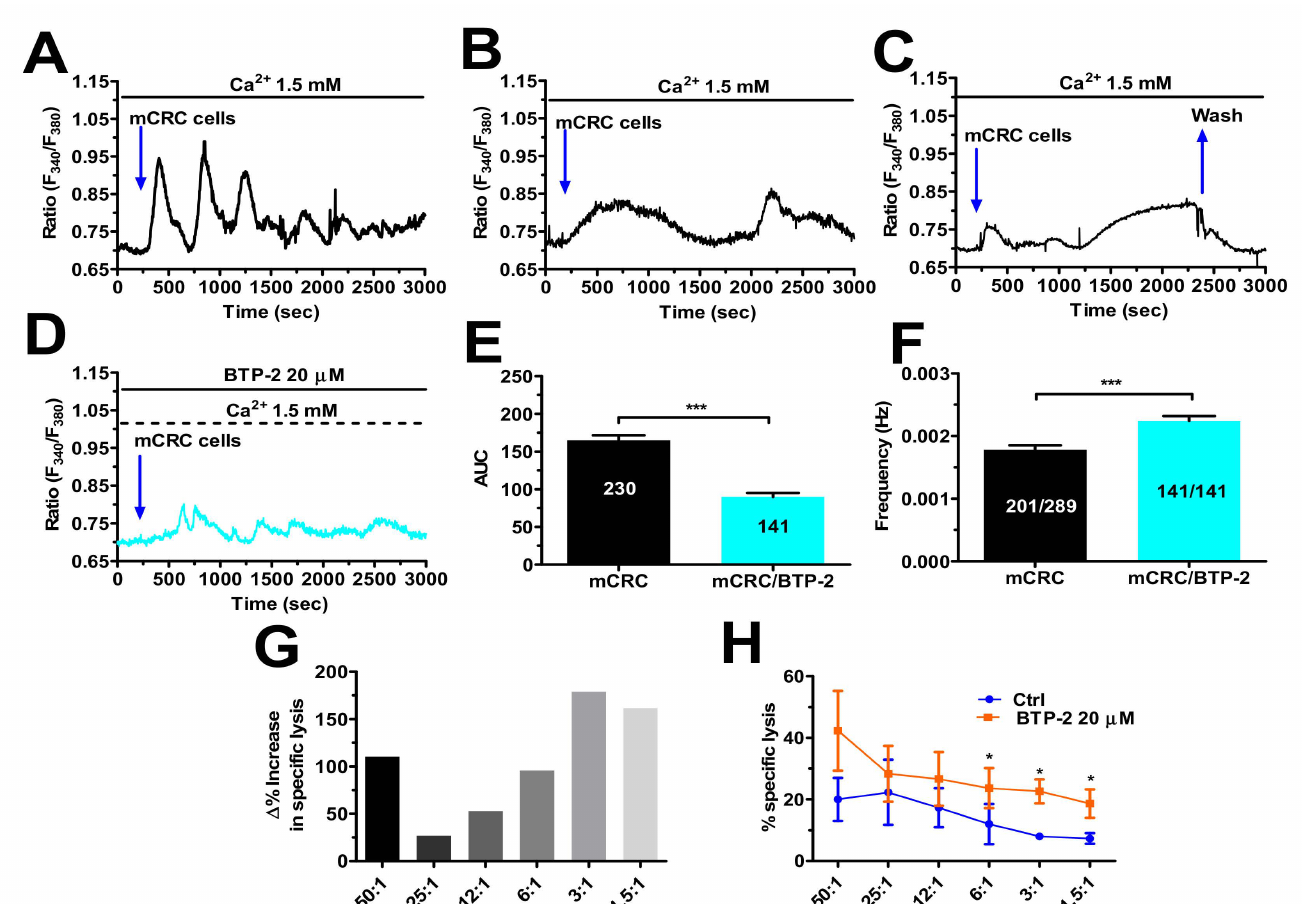
Figure 8. Reducing SOCE with BTP-2 increases TIL cytotoxicity against autologous mCRC cells. ( A – C ): Three distinct patterns of intracellular Ca 2+ signals evoked in TILs plated on 8 mm glass coverslips (4 × 10 5 cells/mL) by the contact with autologous mCRC cells (1 × 10 4 cells/mL): ( A ), intracellular Ca 2+ oscillations (“oscillatory pattern”); ( B ), two slow, intracellular Ca 2+ waves (“slow pattern”); and ( C ), fast Ca 2+ transient followed by a slow increase in [Ca 2+ ] i that ultimately achieved a plateau phase (“plateau pattern”). ( D ) Pre-treating TILs with BTP-2 (20 µ m, 20 min) to selectively inhibit SOCE dampened the Ca 2+ response to TCR engagement by autologous mCRC cells (1 × 10 4 cells/mL) and suppressed the “slow” and “plateau” patterns. ( E ) Mean ± SE of the AUC of the spiking Ca 2+ signal arising in TILs challenged with autologous mCRC cells in the absence (Ctrl) and presence of BTP-2. Student’s t -test: *** p < 0.001. ( F ) Mean ± SE of oscillation